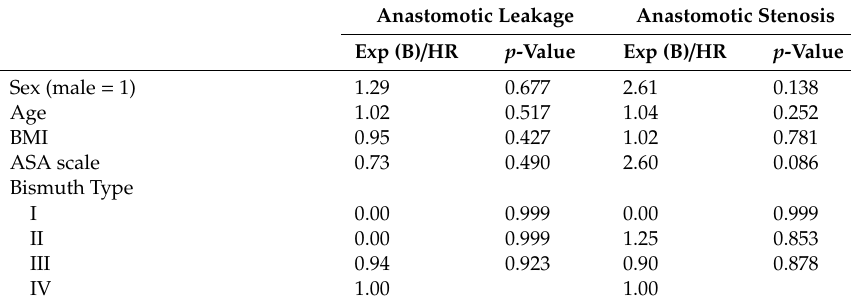
Table 3. Univariable binary logistic analysis of postoperative anastomotic leakage and stenosis of